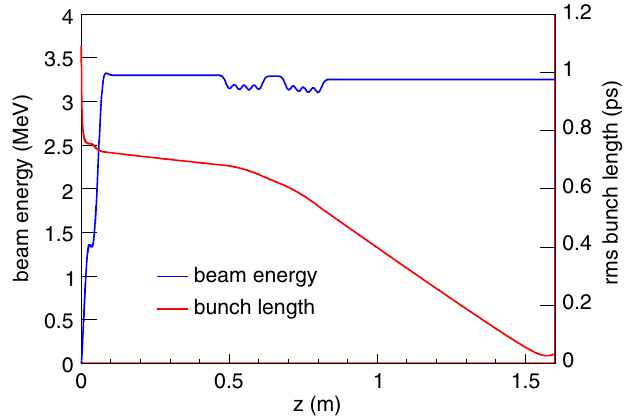
FIG. 4. Beam energy and rms bunch length evolution from the cathode ( z ¼ 0 m ) to the sample ( z ¼ 1 : 6 m ). A beam is gen- erated and accelerated to be 3.30 MeV at the gun. The beam is compressed by more than 30% immediately after the emission at the cathode and then continues being compressed lightly until arriving at the buncher. Then, the beam is decelerated weakly through the buncher to be 3.24 MeV. The beam is compressed by the buncher by a factor of over 10 in the rms length and over 100 in the FWHM (see Fig. 6). The FWHM bunch length is minimal at 1.6 m but the rms length becomes minimal just before this